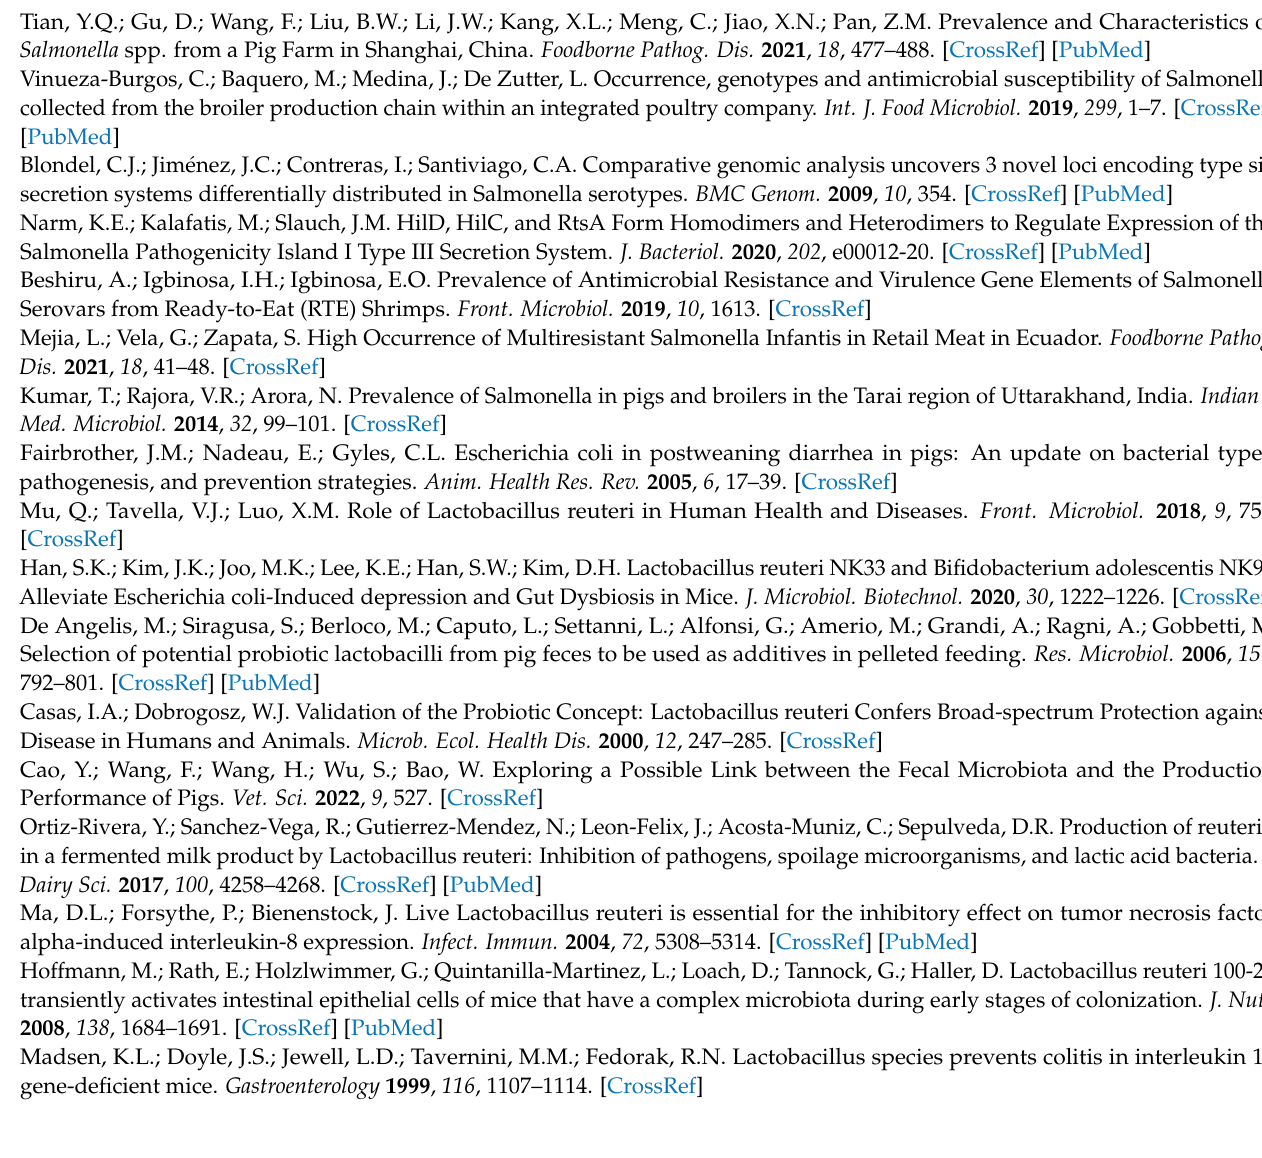
Table S12: KEGG enrichment of differential peaks between the S. enterica BNCC186354 with and without L. reuteri ATCC 53608